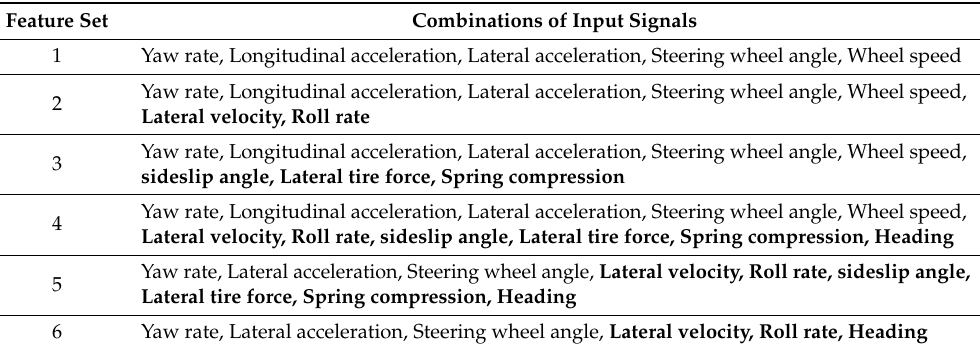
Table 2. Combinations of Input